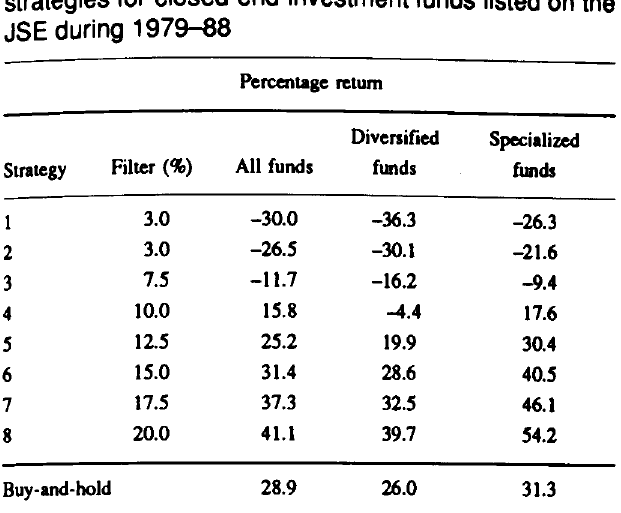
Table 3 Nominal annual rates of return for filter trading strategies for closed-end investment funds listed on the JSE during